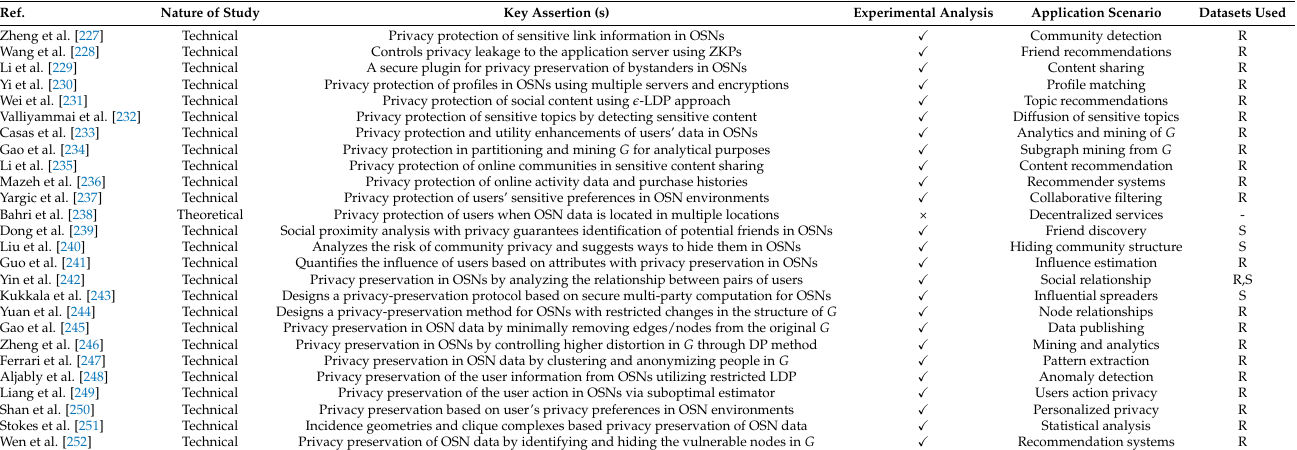
Table 8. SOTA techniques proposed for privacy preservation in OSNs’ application-specific scenarios. Ref.